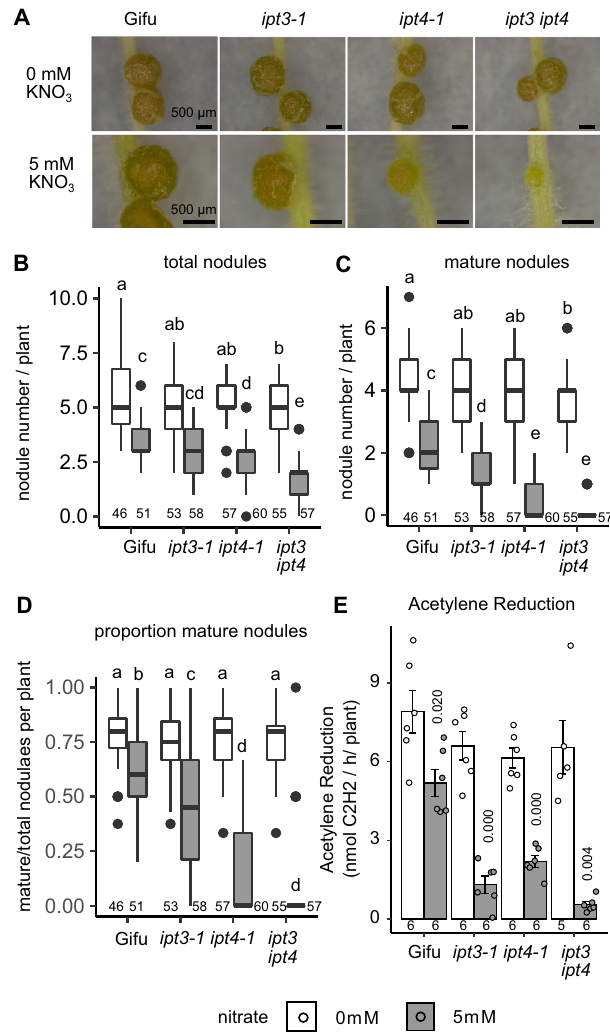
Fig. 3 Ipt3 and Ipt4 are required for resistance to nitrate inhibition of nodulation. A Images of nodules developed in the absence and presence of 5 mM KNO 3 at 14 dpi with M. loti on the indicated host genotypes. Scale bar = 500 μ M. B – D Development of total ( B ), mature ( C ) and the proportion of mature nodules ( D ) in the absence and presence of 5 mM KNO 3 at 14 dpi with M. loti . E Nitrogenase activity assessed by Acetylene Reduction Assay (ARA) at 21 dpi with M. loti in the absence and presence of 5 mM KNO 3 . Box plots show Min, Q1, Median, Q3, Max and outlier values in nodulation assays ( B – D ). Signi fi cant differences among different genotypes and nutrient conditions are indicated by letters ( p < 0.05) as determined by ANOVA and Tukey post-hoc testing with pairwise P -values available in the Source Data fi le. For ARA ( E ), bars show mean ± SE and signi fi cant differences between Gifu and mutants are indicated by the annotated P values as determined by Student ’ s t test. The n values of each group are